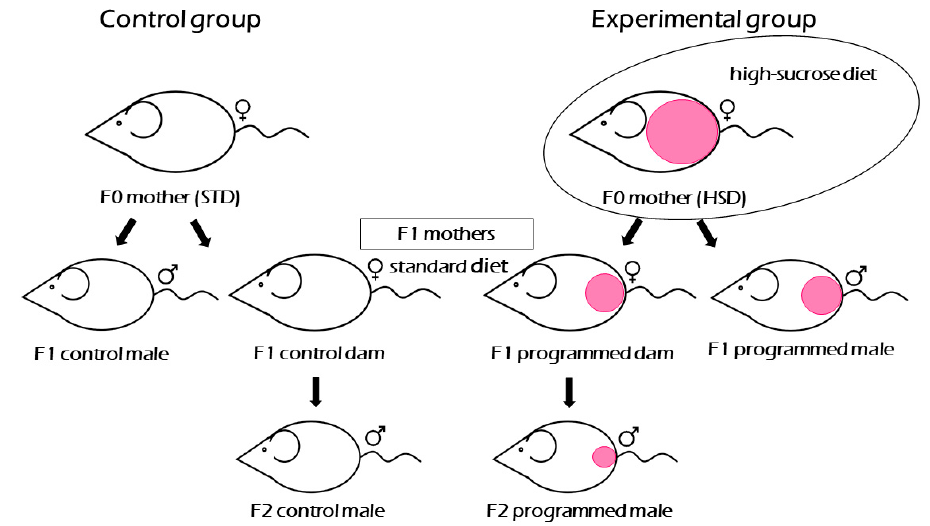
Figure 1. Experimental design. Schematic display of three generations of rats involved in the experiment valid for both SHR and SHR-Zbtb16 strain. Only F0 mothers of the experimental group were fed high-sucrose diet. Current study focuses on F1 generation female groups mothering F2 generation males. STD: standard diet, HSD: high-sucrose diet.